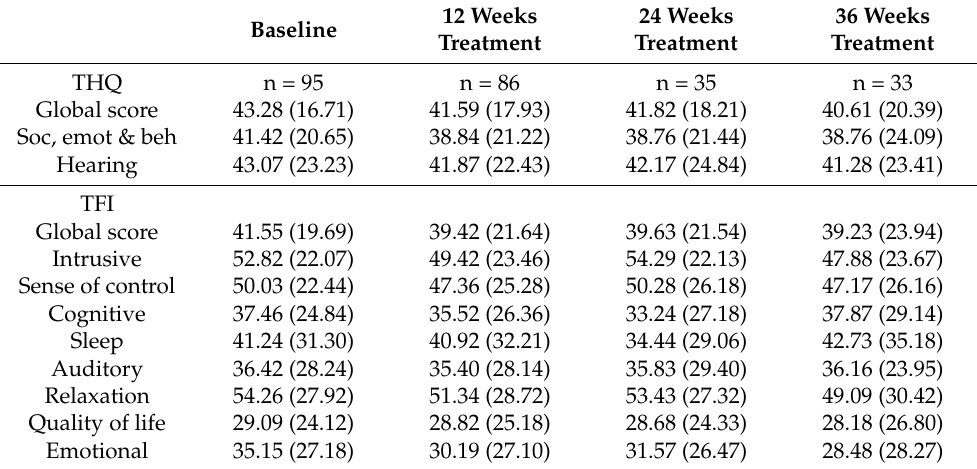
Table 8. Descriptive statistics for the primary (THQ) and secondary (TFI) outcome measures used in within-group